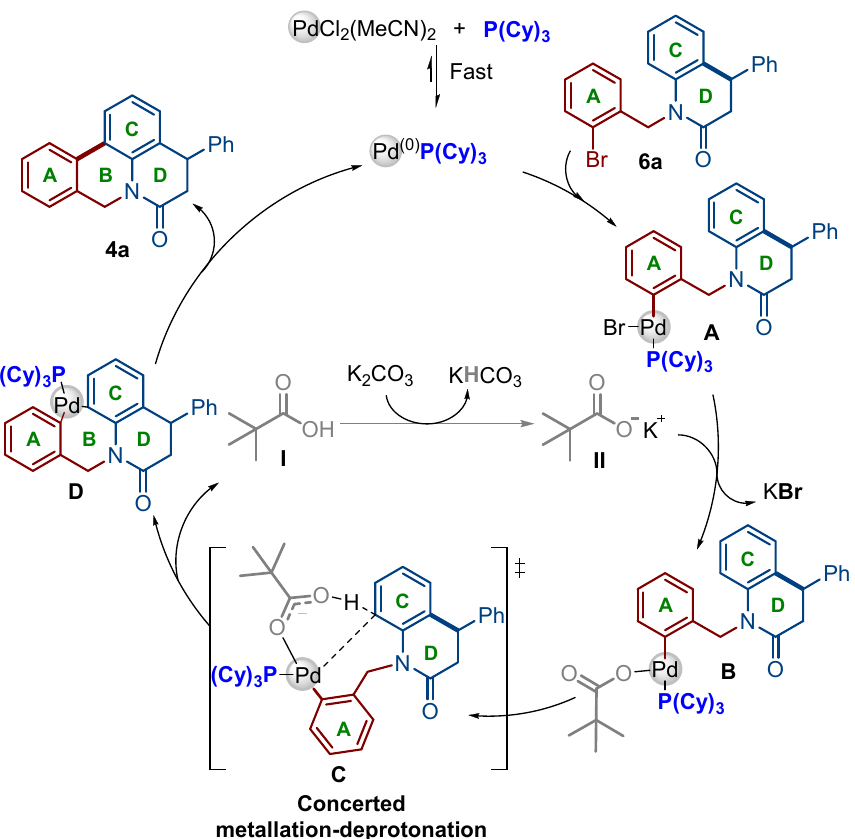
Scheme 5. Plausible mechanism of direct arylation of 3,4 ‐ dihydroquinolin ‐ 2(1 H ) ‐ one 6a.